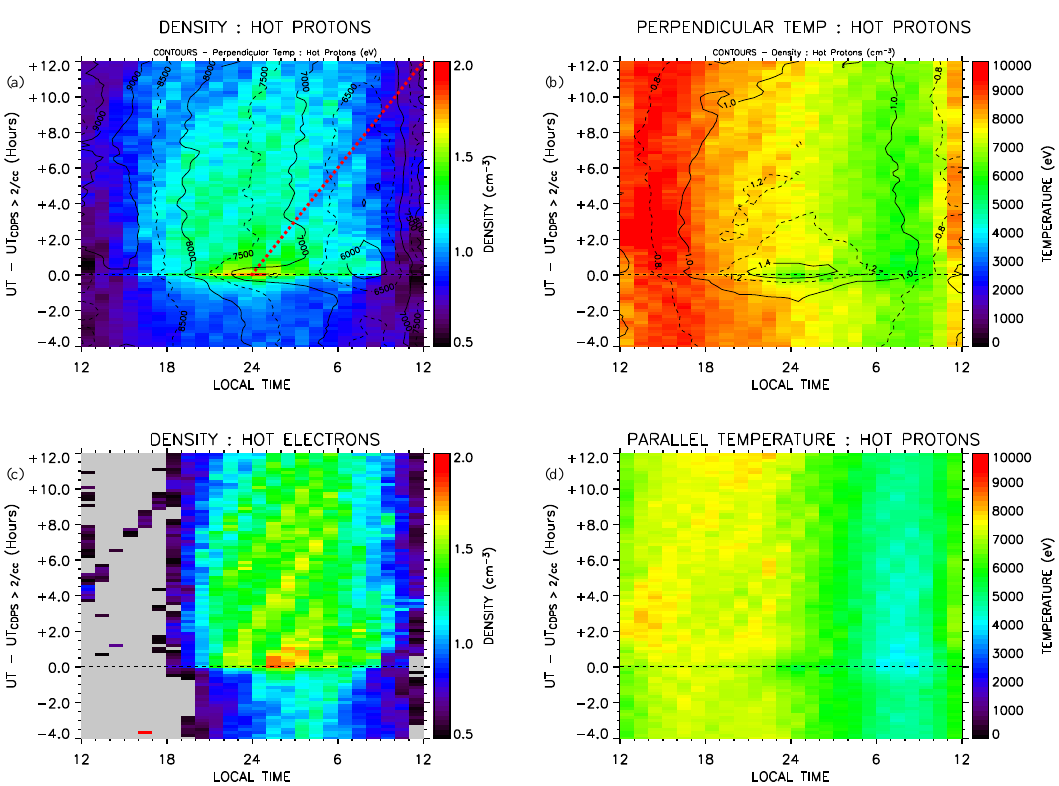
Fig. 2. Results of the superposed epoch analysis for various plasma parameters. The zero epoch times are those of the 1464 initial dense plasma events. The measurements from all operating spacecraft are binned and averaged according to 24 local time bins (x-axis) and 96 ten- minute intervals in time. The total time interval ranges from − 4 before to + 12h after the zero epoch (“0.0”). (a) Superposed epoch plot of the ion density measurements, with the perpendicular ion temperature over-plotted as smoothed contours. In this plot, the expected dawnward transport due to corotation is illustrated by the dashed red line. (b) Superposed epoch plot of the perpendicular ion temperature measurements, with the ion density over-plotted as smoothed contours. (c) Superposed epoch plot of the electron density. (d) Superposed epoch plot of the parallel ion temperature. Respective color palettes are given on the right side of each plot. See text for further